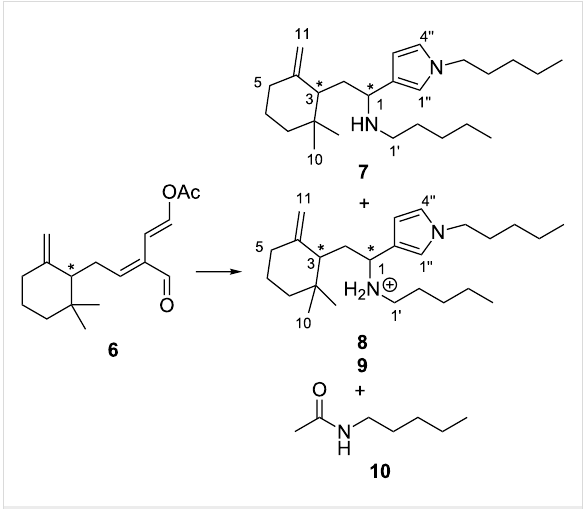
hydes, 5 (from Caulerpa ashmeadii ) [8] and onchidal ( 6 ) [9,10] (from the defensive secretion of the mollusc Onchidella binneyi ) also exhibit biological properties including feeding deterrence, antibacterial and anticholinesterase